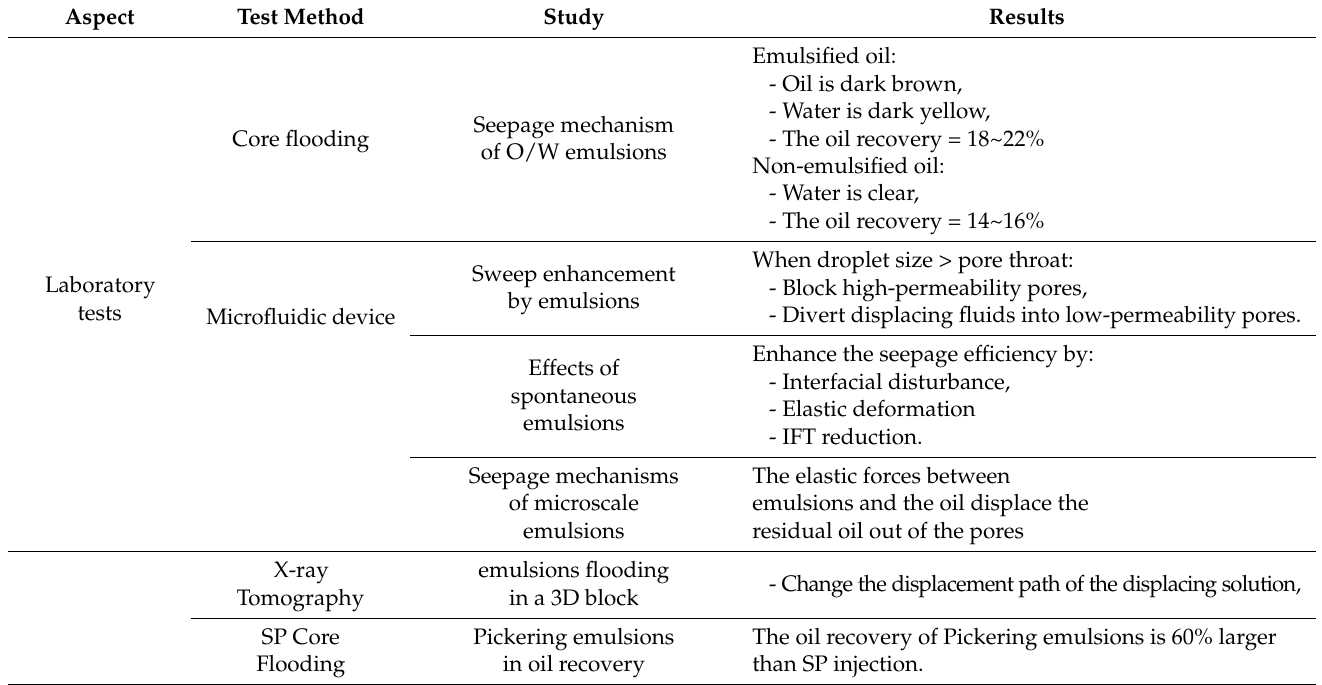
Table 3. Studies on the effects of heavy oil emulsions on EOR